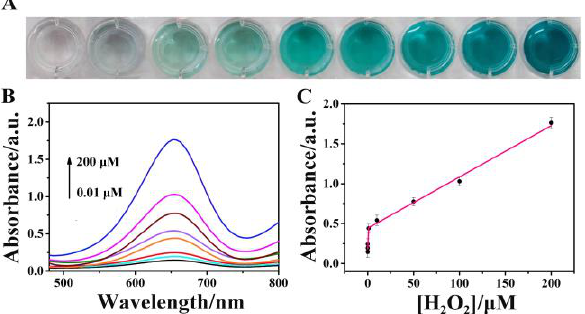
Figure 3. Photographs ( A ) of the TMB + H 2 O 2 colorimetric reaction solutions facilitated by various H 2 O 2 concentrations in the range of 0.01 – 200 μM and ( B ) UV – vis absorption spectra. ( C ) Relationship between absorbance at 650 nm in reaction solutions ’ UV – vis absorption spectra and H 2 O 2 concentration. Standard deviations are shown by error bars ( n = 5).